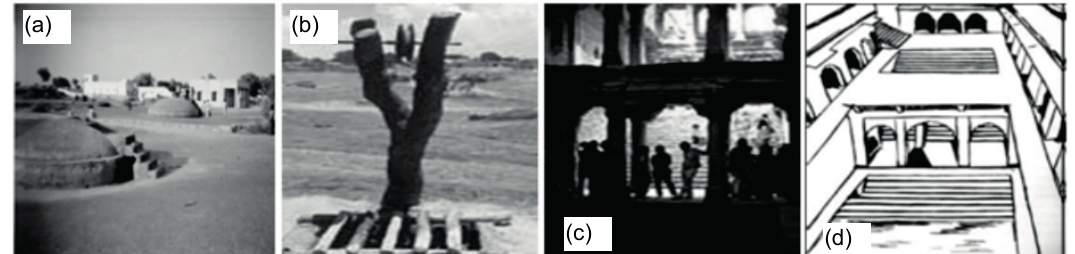
Fig. 1 (a) Kund/Kundi, (b) Kuis/Beris, (c) Baoris/Bers, (d) Jhalara.